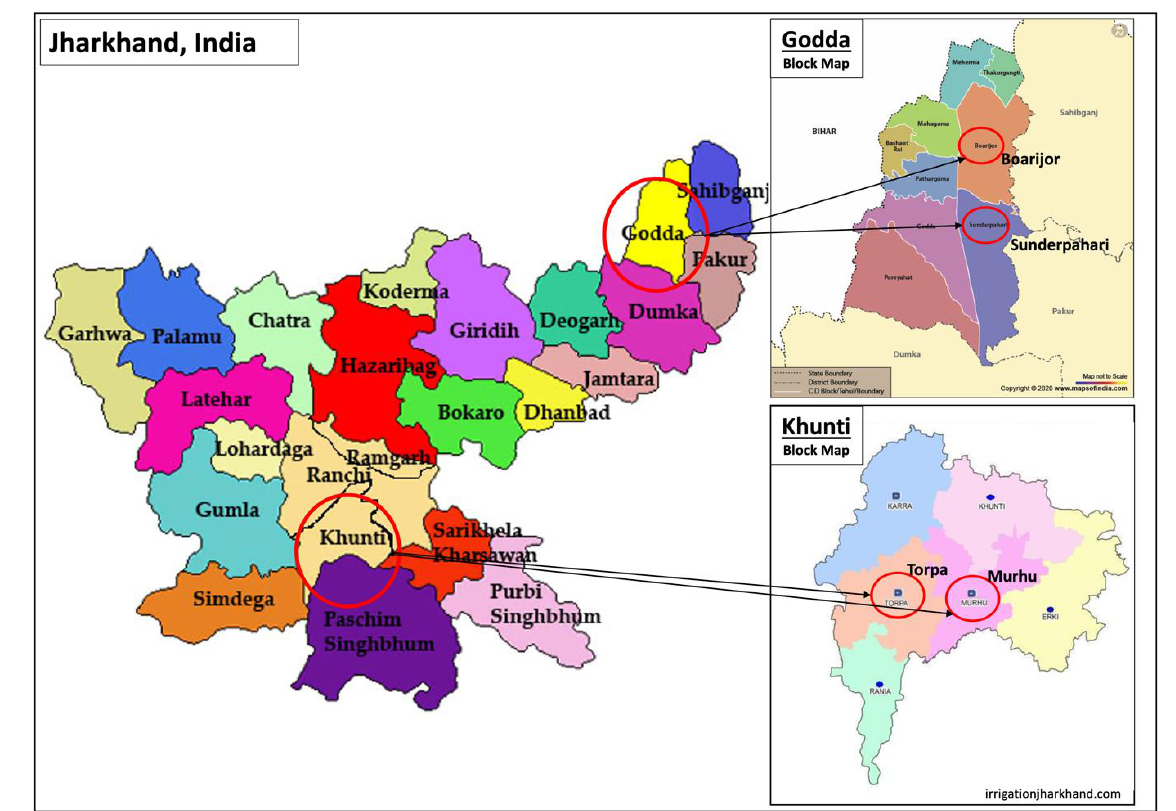
Figure 1. Selection of study blocks in Godda (Boarijor and Sunderpahari) and Khunti (Torpa and Murhu) districts of Jharkhand, India.